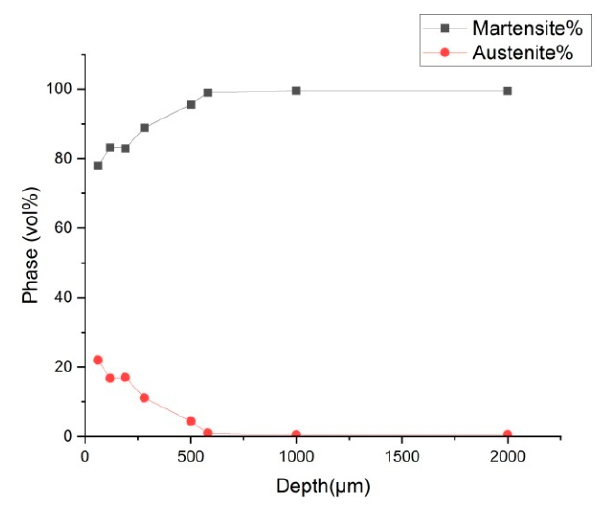
Figure 17. The content of the microstructure from XRD.